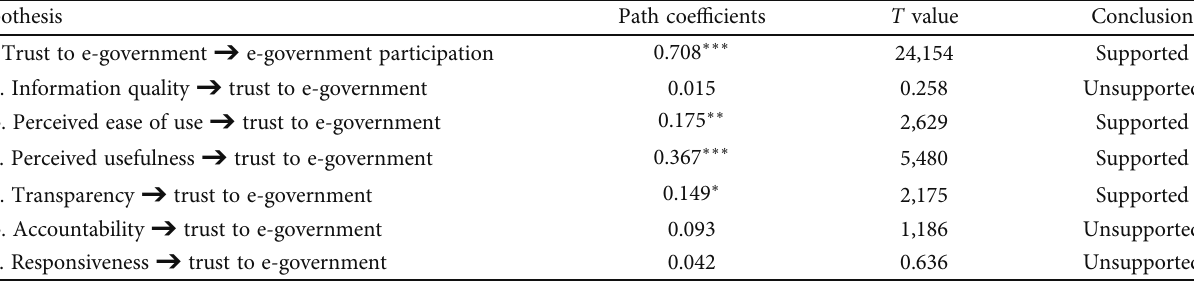
Figure 3: Structural model results. Table 7: Summary of hypothesis